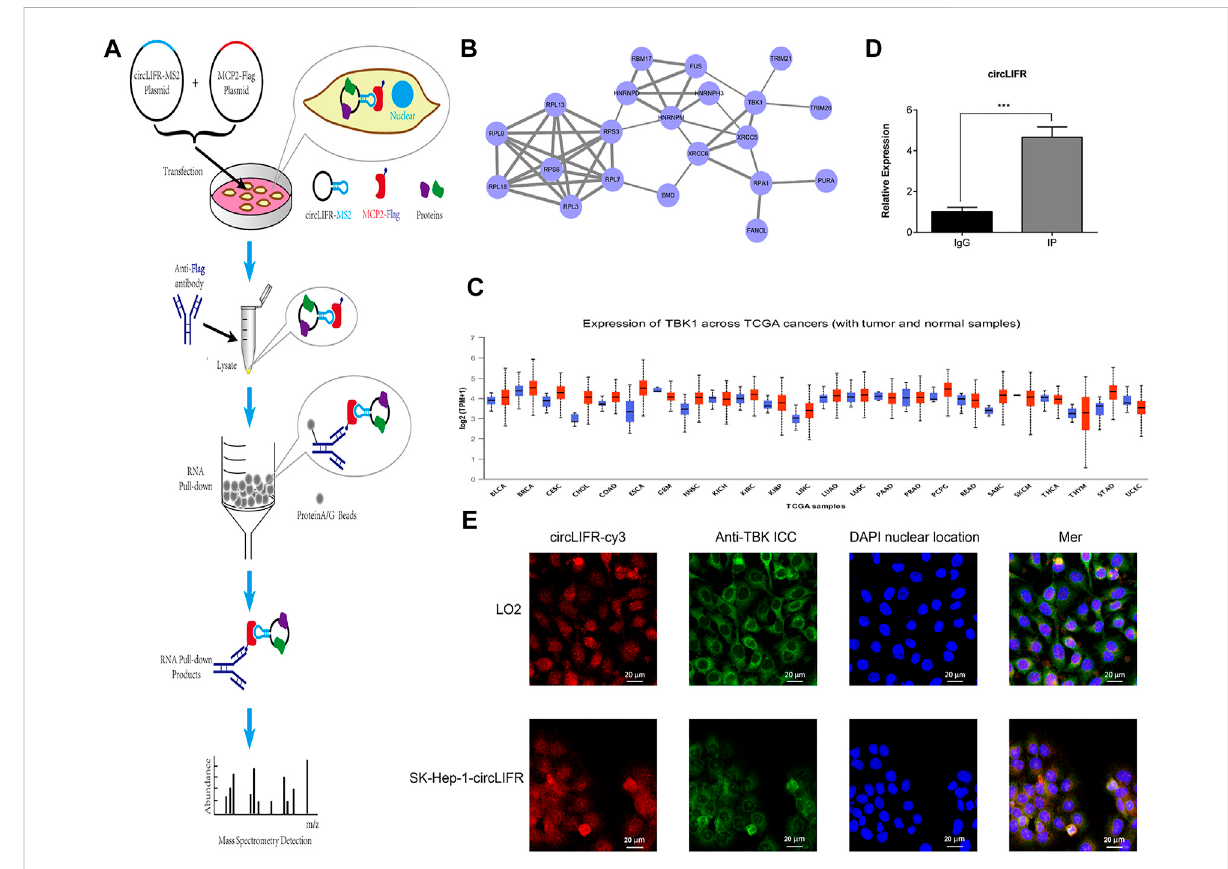
FIGURE 3 RNApulldownforCircLIFR. (A) SchematicdiagramforpulldowndetectionofthecircLIFRgene; (B) PPIanalysisofthedetectedproteinsbymass spectrometry; (C) pan-cancer expression level of TBK1 in TCGA cohort, (obtained from the UALCAN website); (D) RIP test veri fi ed that overexpression of circLIFR signi fi cantly promoted speci fi c binding between TBK1 proteins.* p < 0.05; ** p < 0.01; (Student ’ s t-test); (E) FISH and IF detection for circLIFR and TBK1 in LO2 cells that enhanced expressing circLIFR.